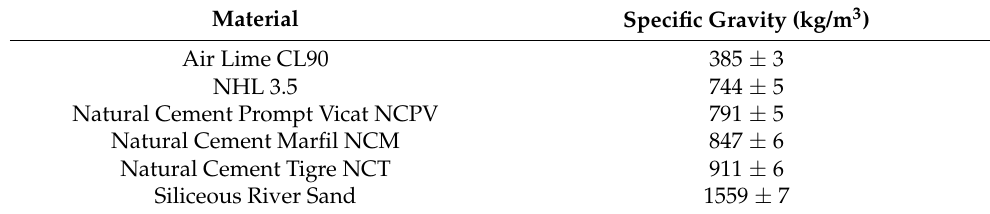
Table 2. Specific gravity of